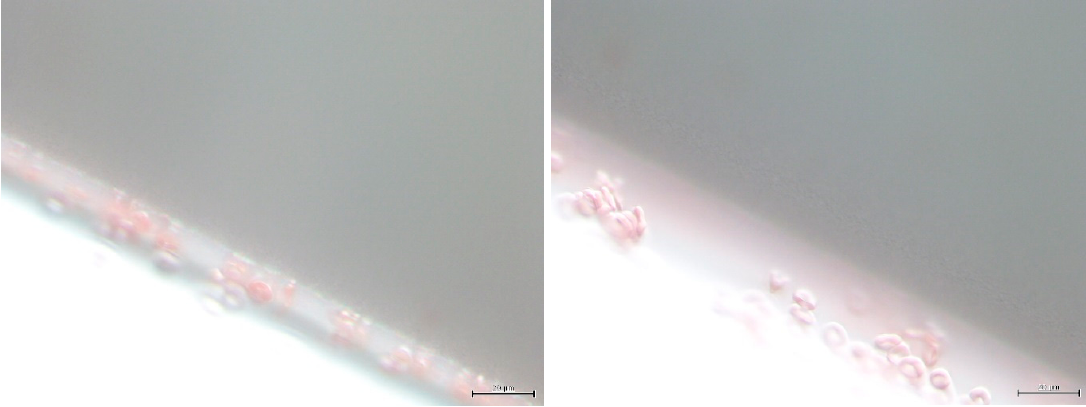
Figure 15. Light microscopy of RBC flow between the glass surface (transparent area) and the outer surface of a polymer (polysulfone) capillary (grayish area). Scale bar 20 µ m. Most of the cells retain normal discocyte shapes.